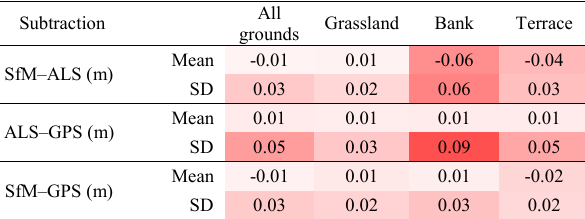
Table 3. Mean and standard deviation of elevation differences be- tween SfM, ALS, and RTK GPS. Colour intensity indicates the de- viation from zero value with minimum/maximum of ± 0 . 09m. Table 3 . Mean and standard deviation of elevation differences between SfM, ALS and RTK GPS. Colour intensity indicates the deviation from zero value with minimum/maximum of ±0.09